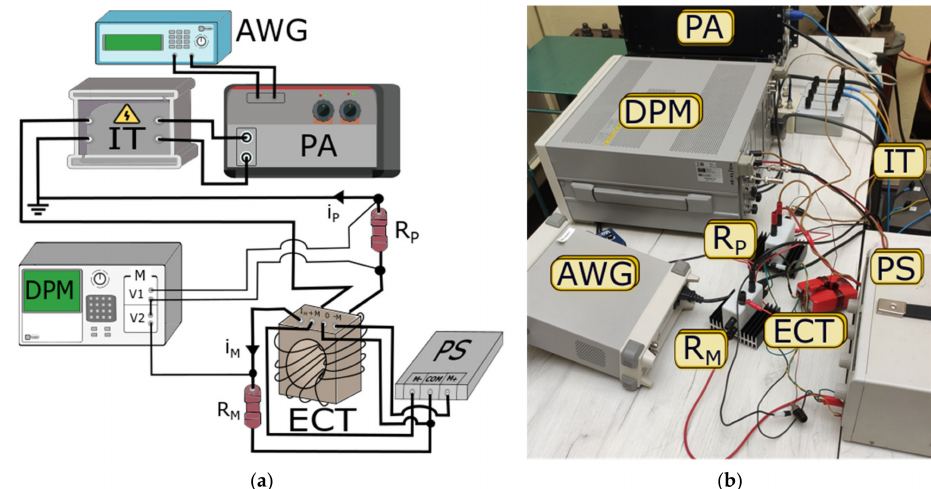
Figure 4. The measuring circuit: ( a ) electrical diagram; ( b ) photo of the laboratory